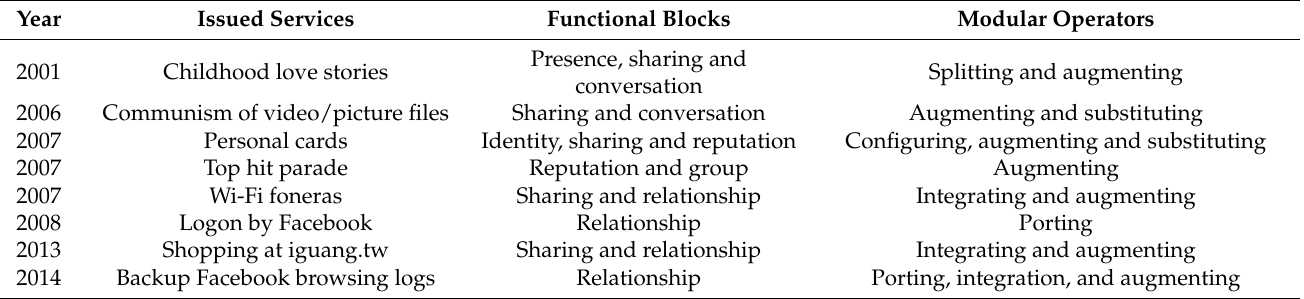
Table 1. Youthwant builds the platform of functional blocks by manipulating modular